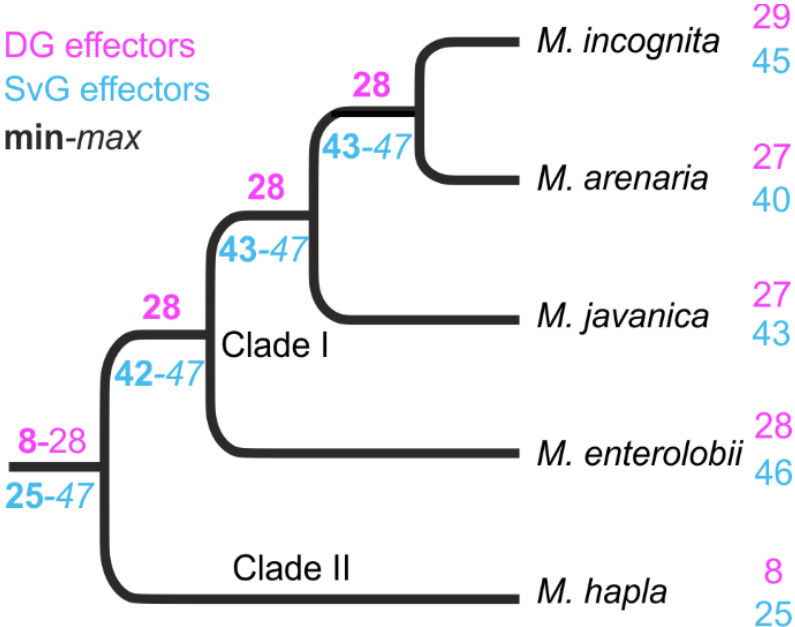
Figure 2. Reconstruction of ancestral numbers of homologues of M. incognita effectors across the Meloidogyne phylogeny. Based on the mapping of known M. incognita SvG (cyan) and DG (magenta) effectors on the genomes of five Meloidogyne species, ancestral numbers were reconstructed using parsimony. Minimal effector numbers are given in bold at the corresponding branches and maximal numbers in italics, depending on whether the equi-parsimonious absence/presence of effectors are considered actually absent/present.